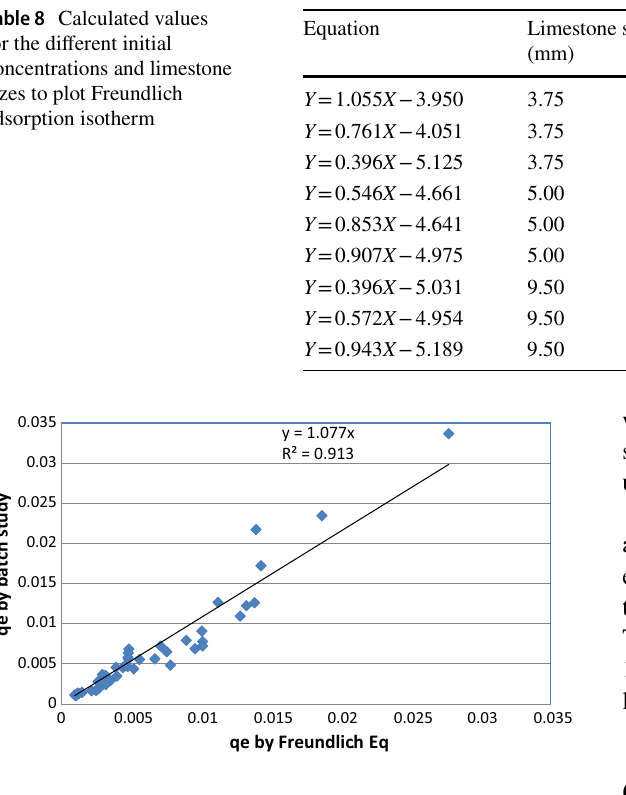
Fig. 10 Amount of heavy metal removal (Cu) by batch study and Fre- undlich